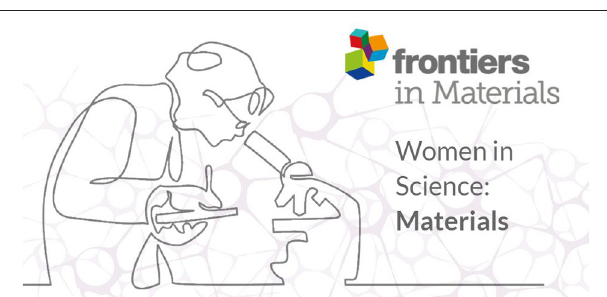
FIGURE 1 | “Women in Science: Materials” collection in Frontiers in Materials